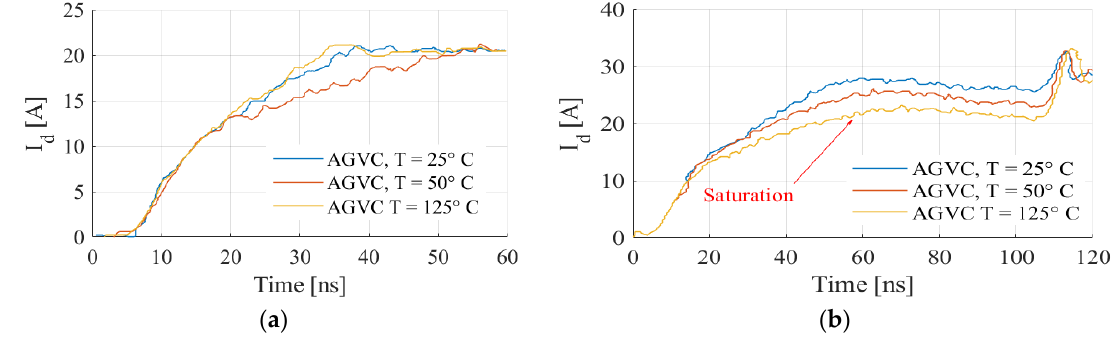
grint = 4 V, t int = 120